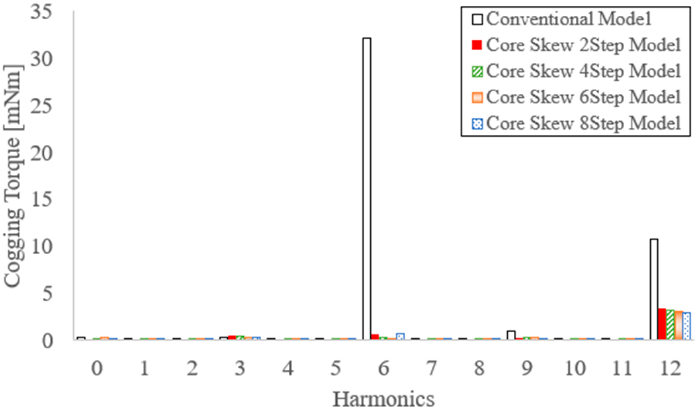
Figure 17. Spectra of cogging torque according to the number of steps.